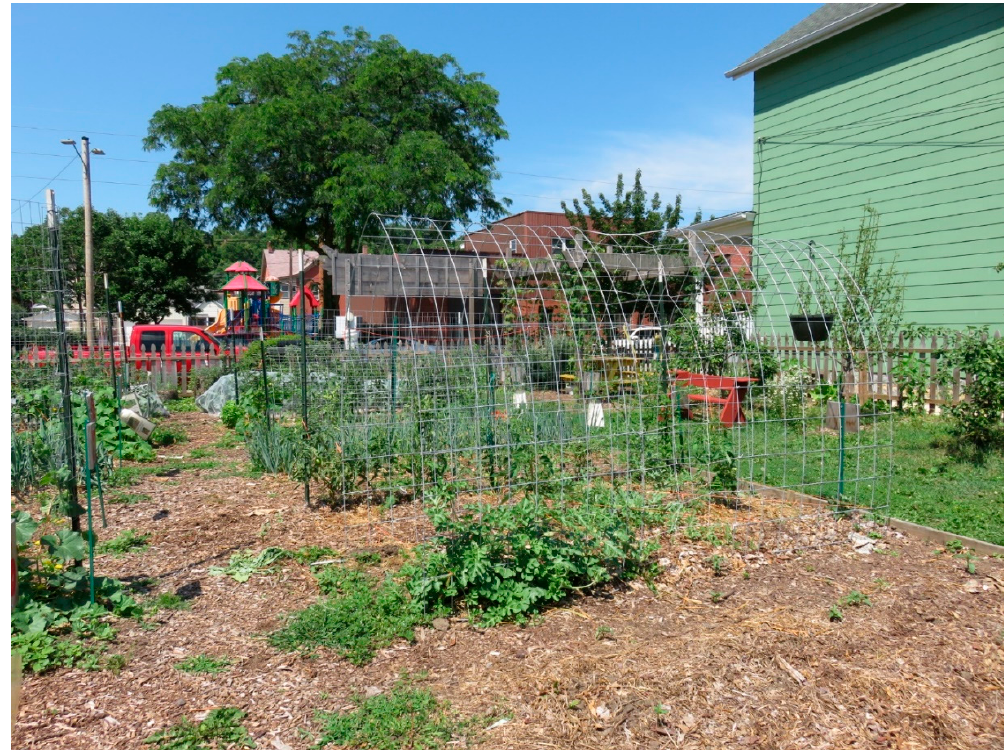
Figure 2. The Washington Neighborhood Community Garden (foreground) and Orange Park (background).